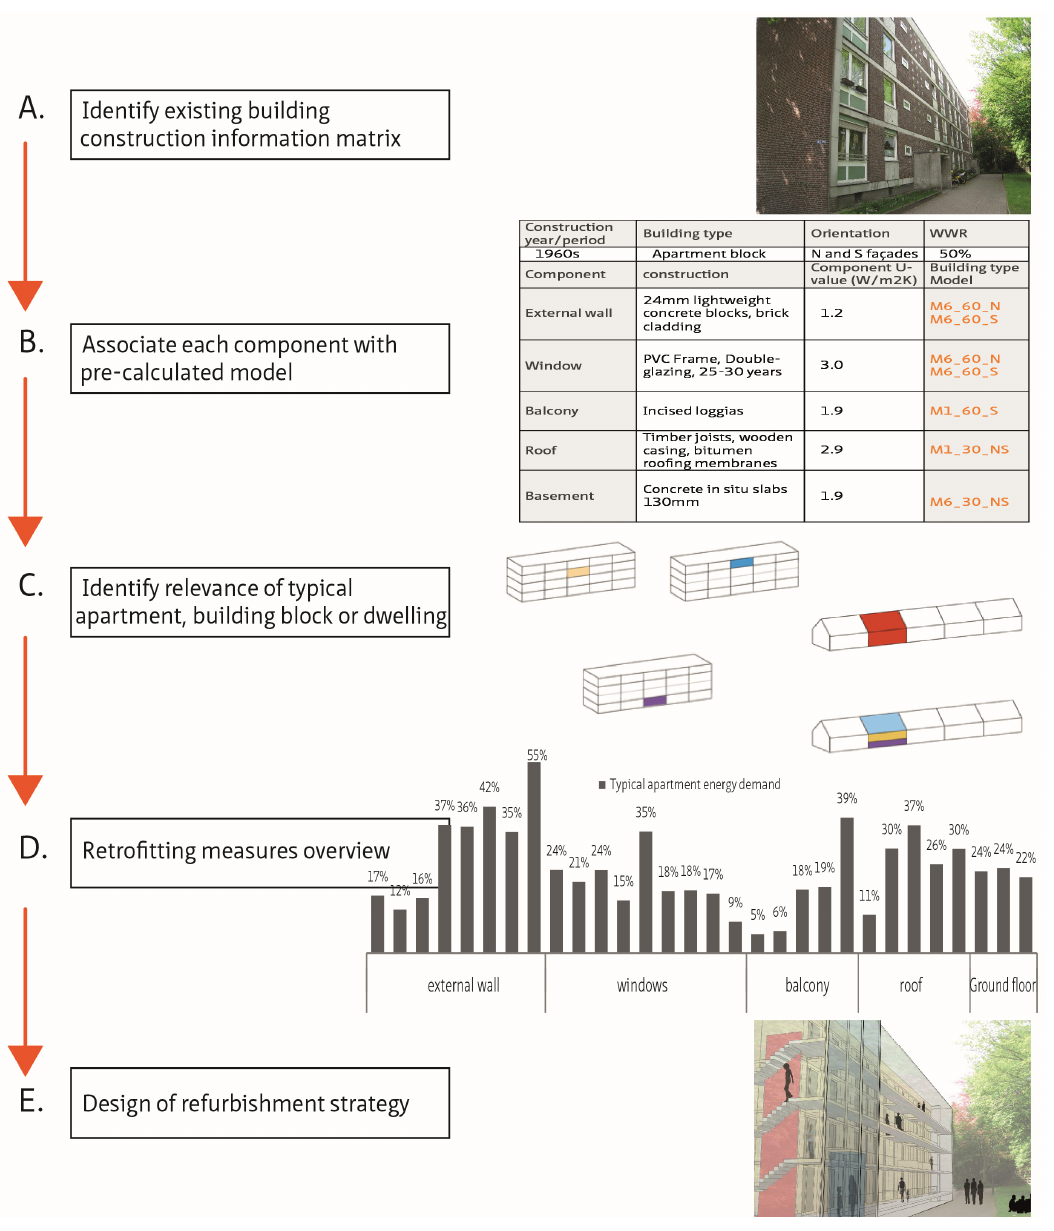
Figure 2. Steps to associate an existing building with the façade refurbishment toolbox (FRT) approach pre-calculated models. In this way, an indication of energy saving potential of different retrofitting measures is available without new